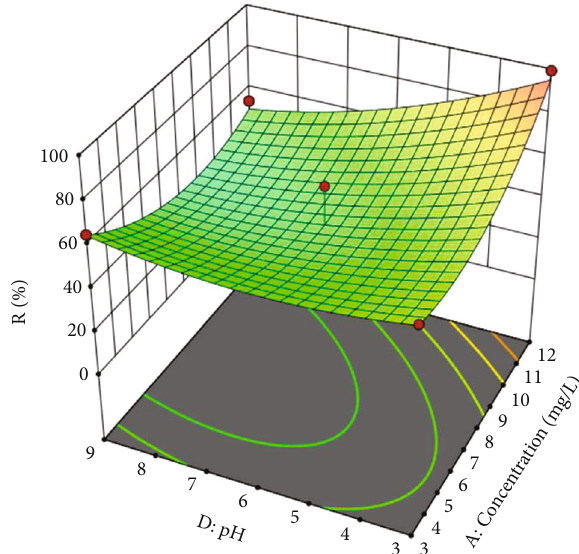
Figure 3: E ff ects of pH and concentration on adsorption